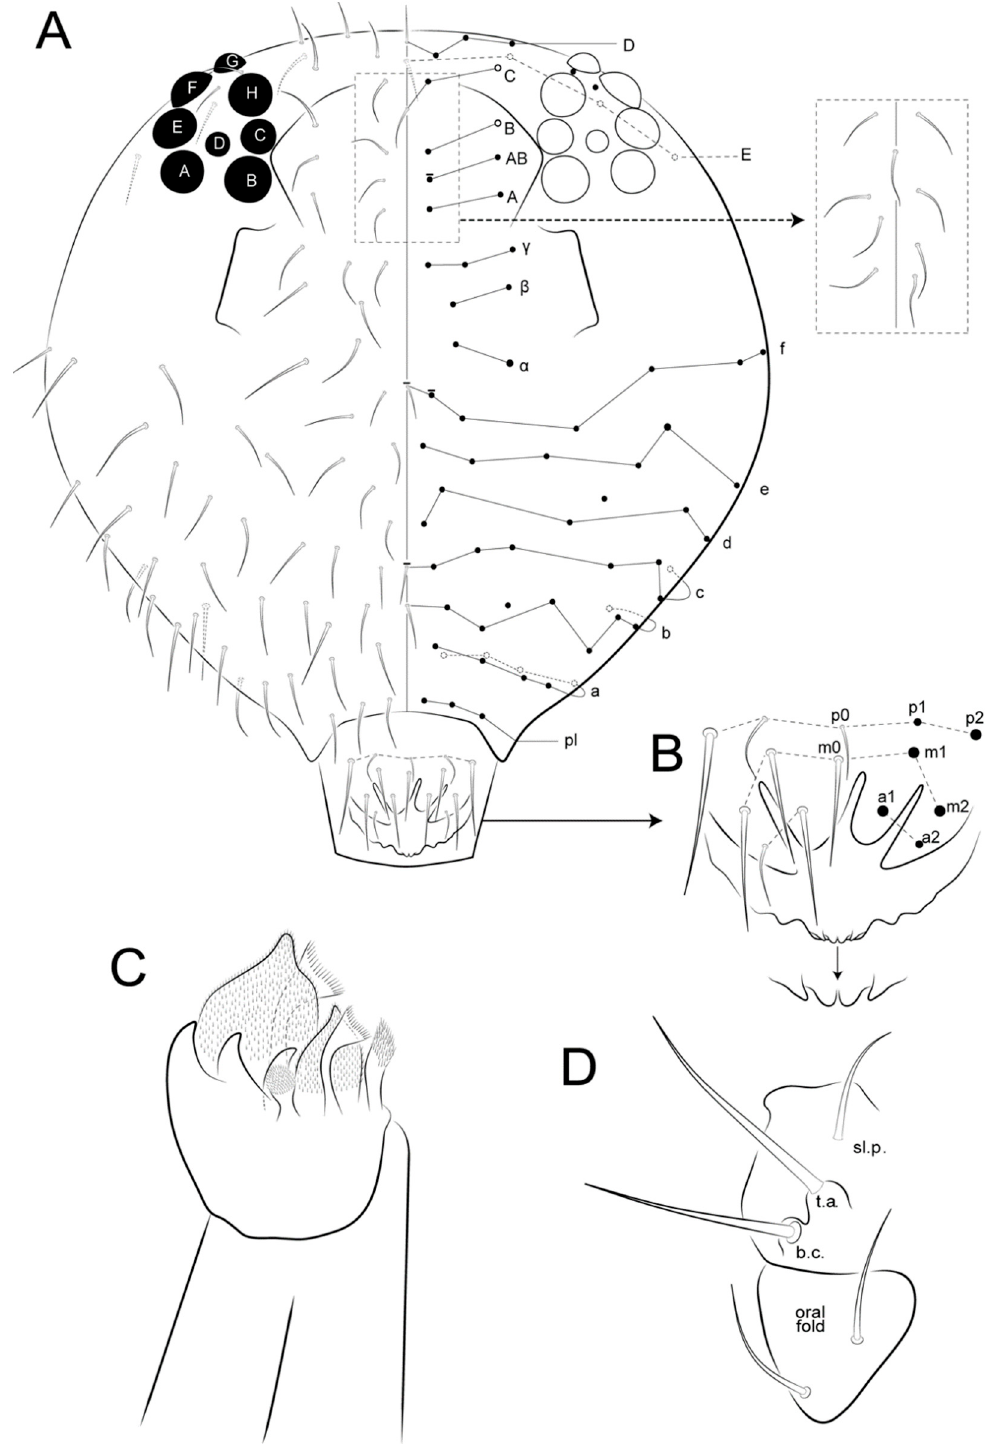
Figure 9. Arlesminthurus caatinguensis sp. nov., female: ( A ) complete head dorsal chaetotaxy (pre ‐ labral, clypeal, frontal, interocular and occipital); the left side shows the chaetae as observed and the right side shows a schematic representation; arrows show variation interocular chaetae and labral region, respectively; ( B ) labrum, arrow indicates the labral papillae; ( C ) left maxilla apex (ventral side); ( D ) maxillary outer lobe (left side).